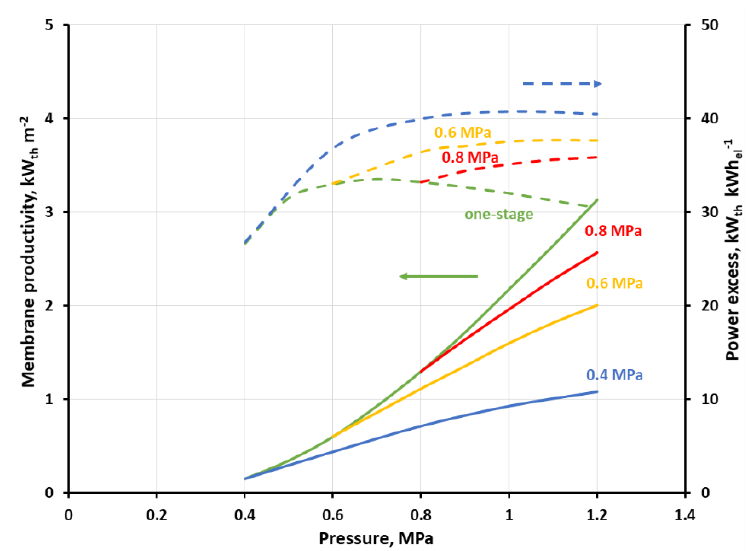
Figure 11. Membrane productivity (solid lines) and power excess index (dashed lines) as a function of gas pressure on the feed side for one-stage configuration and two-stage configuration at feed gas pressure of 0.4, 0.6 and 0.8 MPa in the first stage inlet when polyimide (UMS-A5) membrane is used.